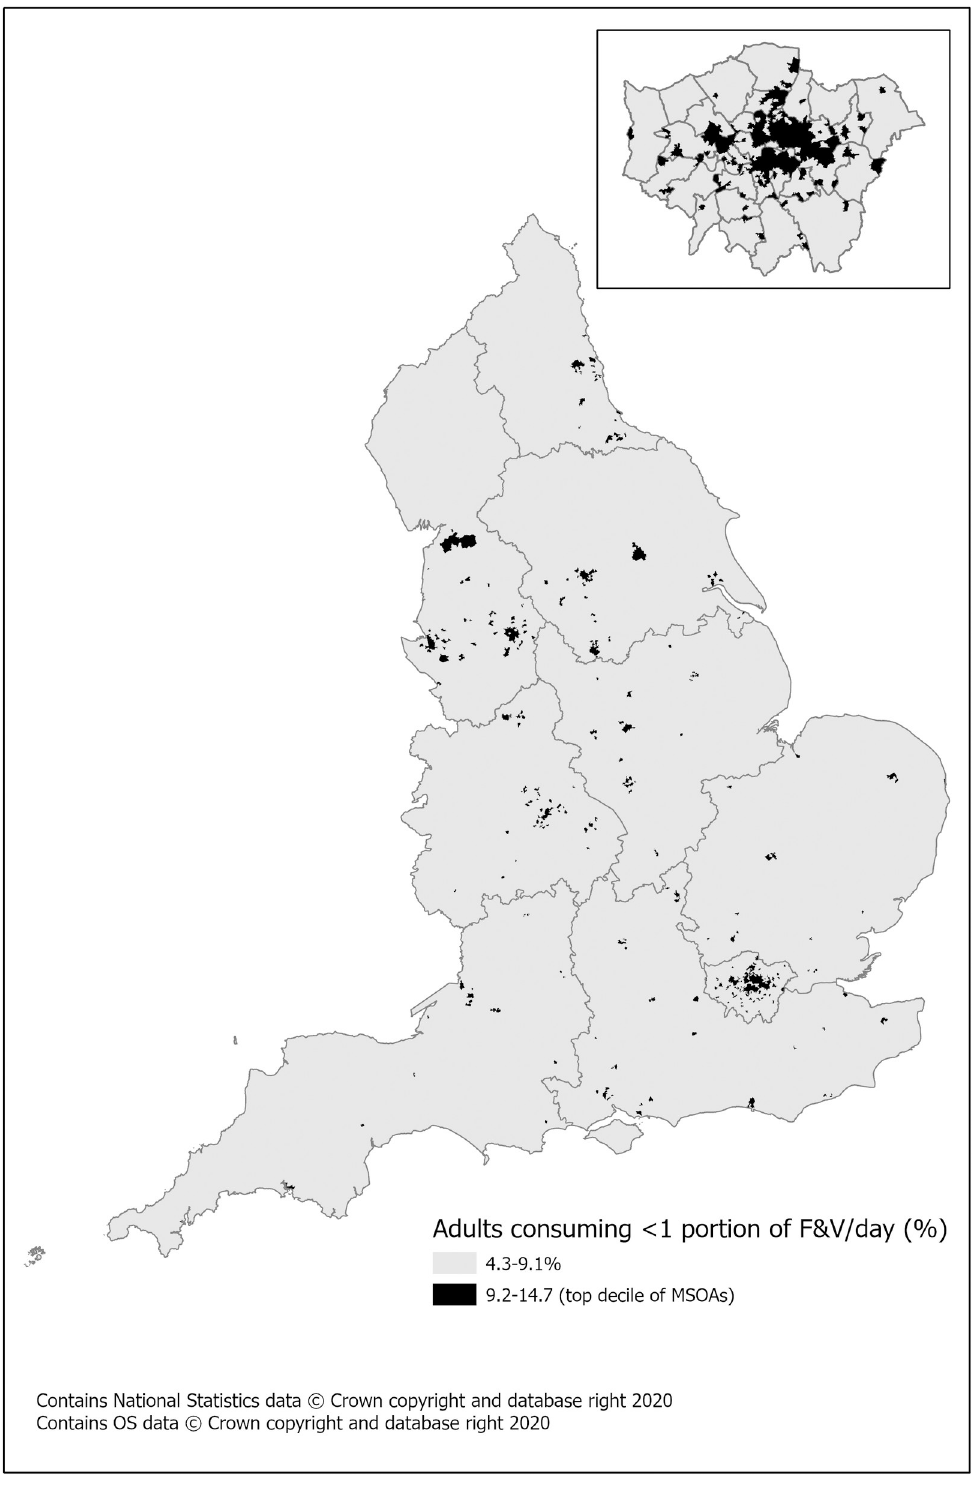
Fig 3. Estimated prevalence of consuming less than 1 portion of ‘five a day’. This measure includes 100% juice for adults by MSOA (2018 population) with inset of London.